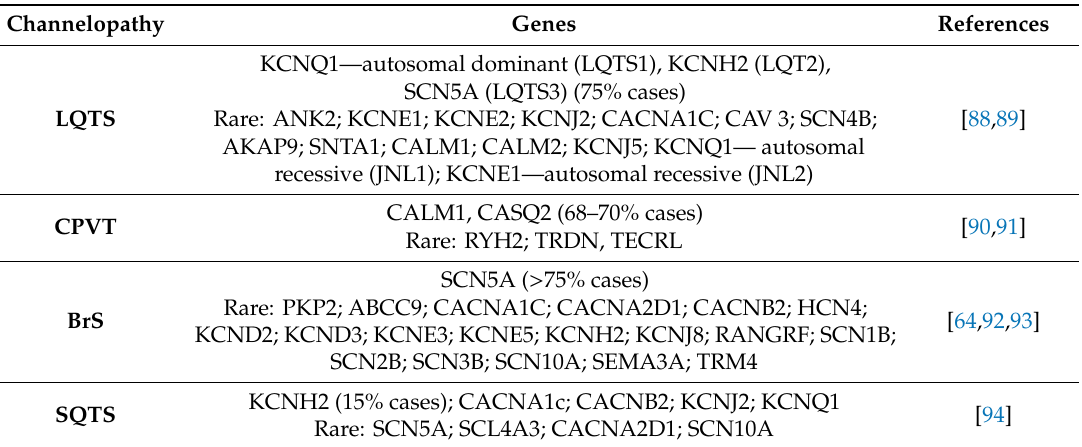
Table 5. Genes associated with cardiac pediatric